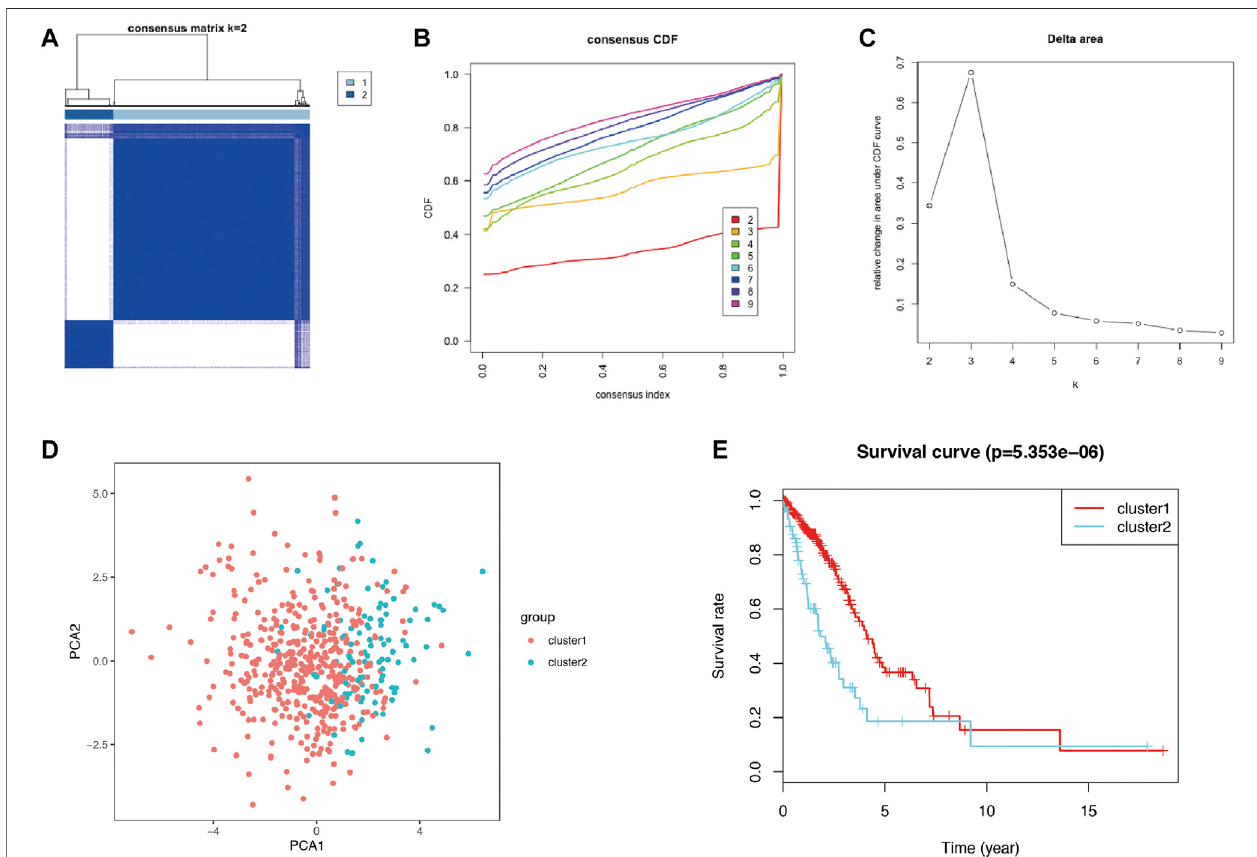
FIGURE 4 | The consensus clustering analysis and the principle components analysis. (A – C) The consensus clustering analysis of the 28-prognostic ARGs, inferring the optimal number of clusters, the lowest proportion of ambiguous clustering, and the best CDF value by taking the k value of 2. (D) The principle component analysisoftheprognosticautophagy-relatedgenesinLUADpatients. (E) Kaplan – Meieranalysisbetweencluster1andcluster2.ARGs,autophagy-relatedgenes;CDF, cumulative distribution function; LUAD, lung adenocarcinoma.